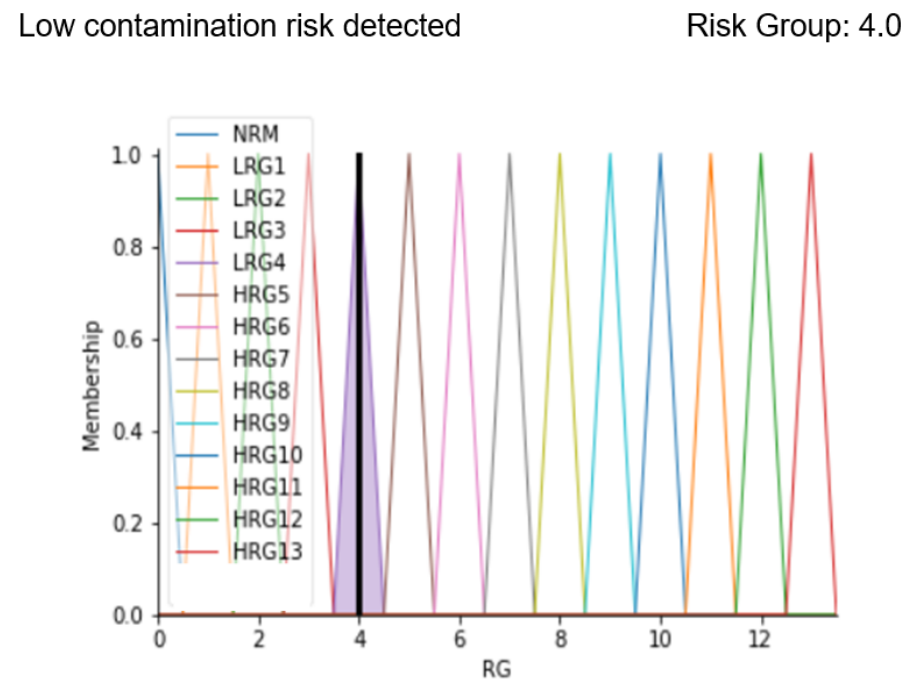
Figure 10. Results display for case study 1.